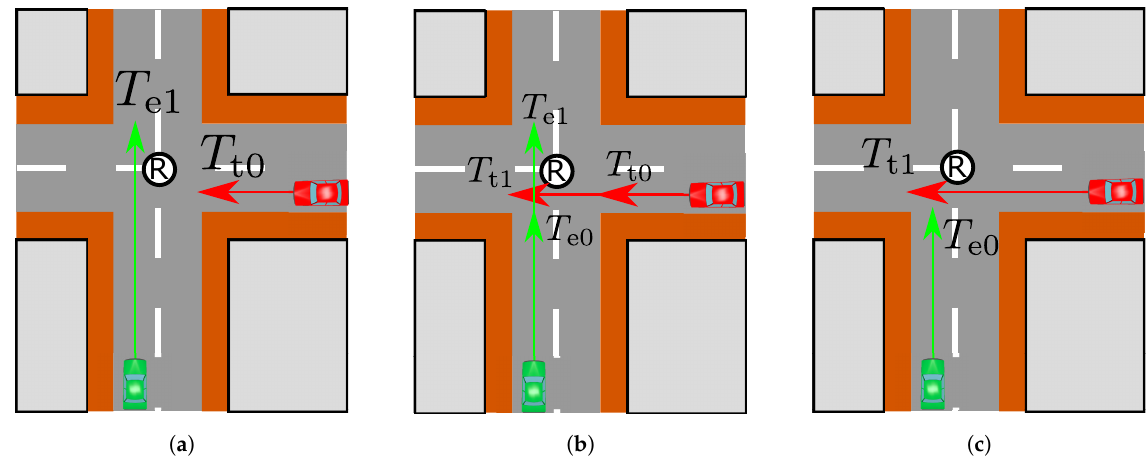
Figure 2. The three classified driving patterns: ( a ) The driving pattern in which the ego vehicle crosses first. ( b ) The driving pattern in which both vehicles are about pass through the intersection. and ( c ) The driving pattern in which the target vehicle crosses